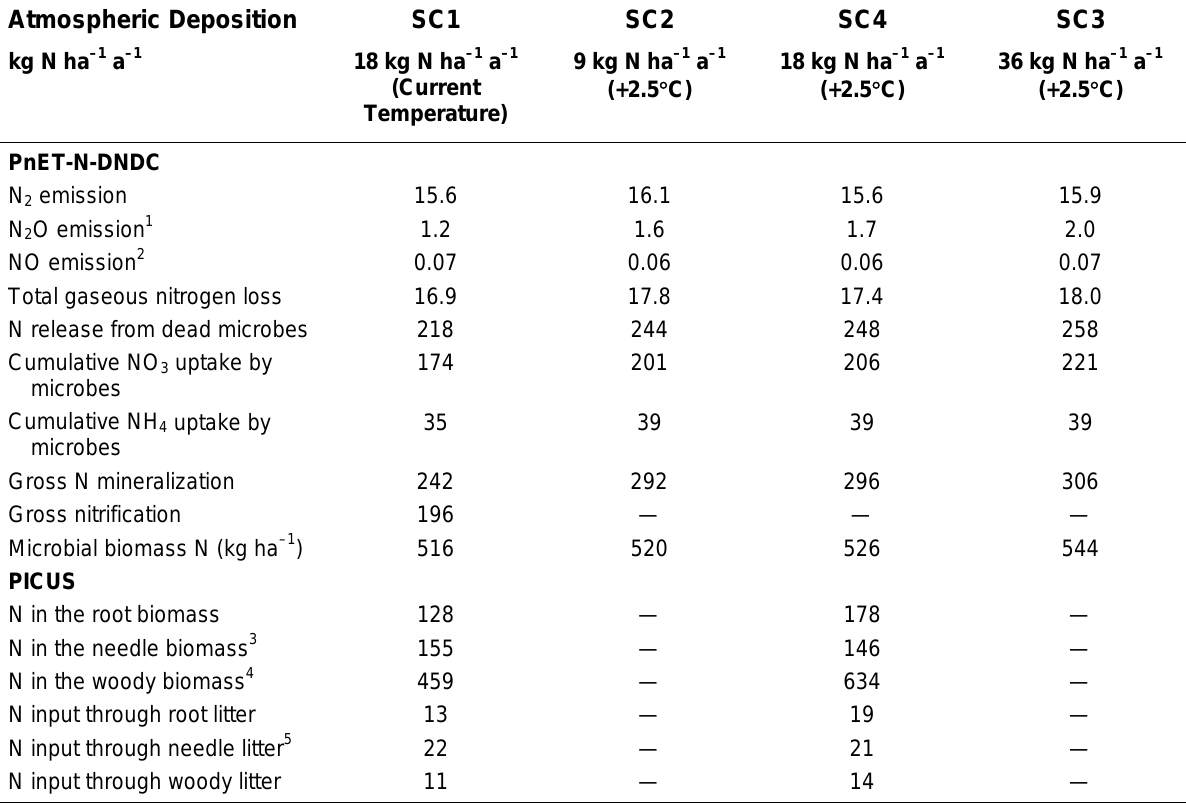
Results of PnET-N-DNDC and PICUS for the Main Parameters within the Scenarios Atmospheric Deposition SC1